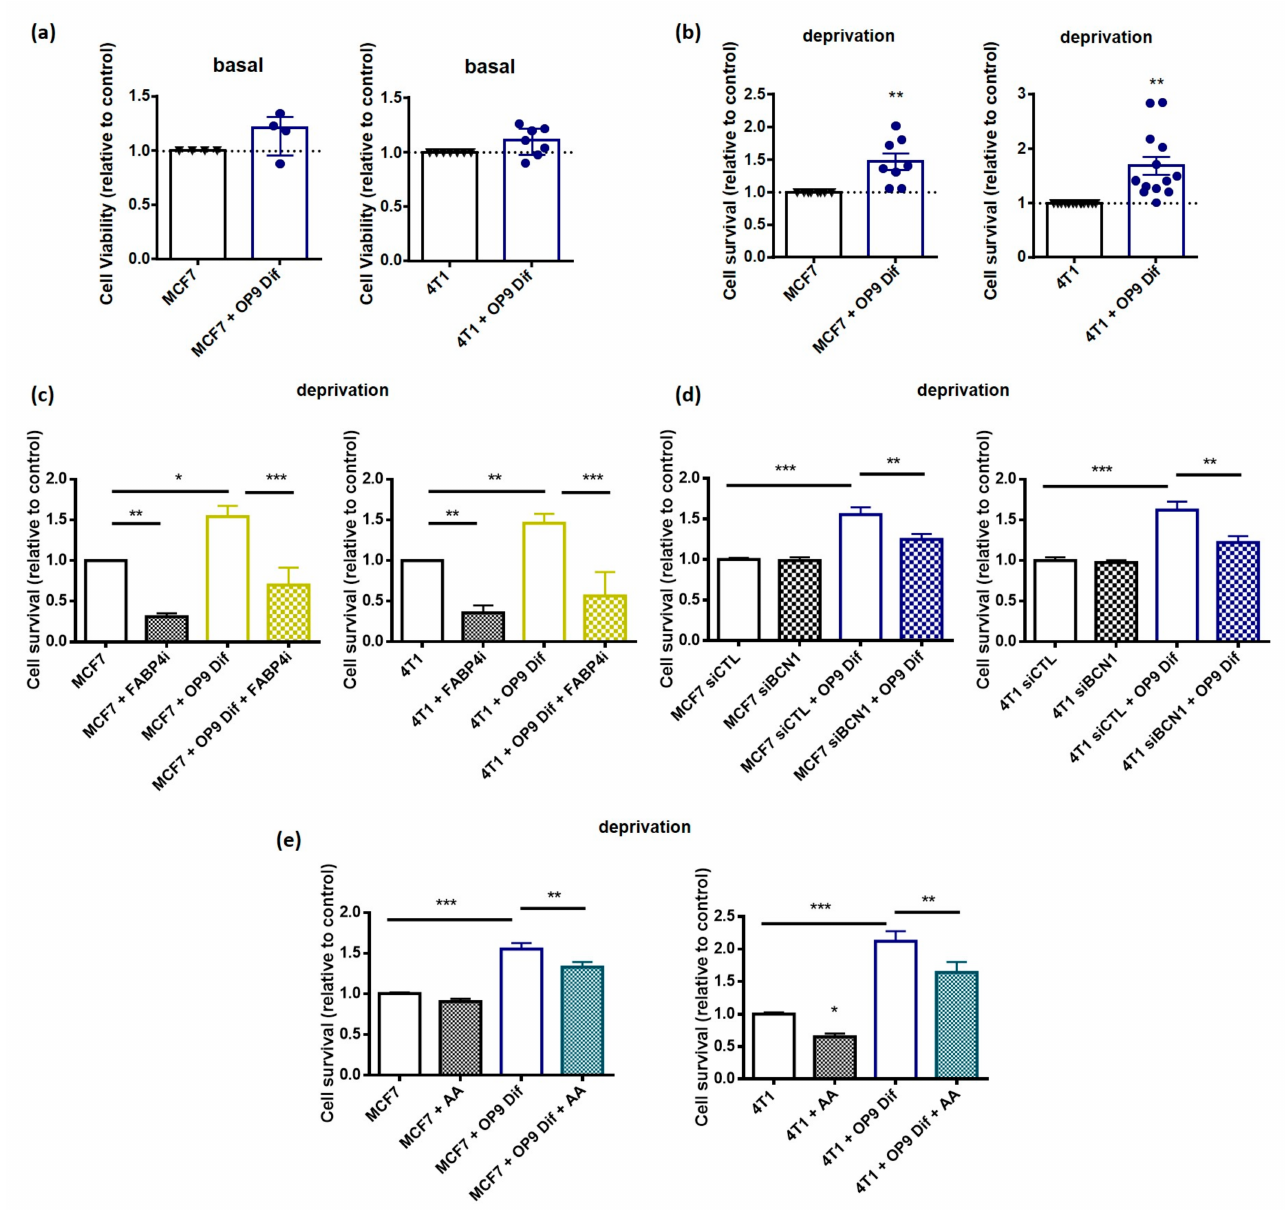
Figure 6. Activation of autophagy by adipocytes promotes cancer cell survival in nutrient-deprived conditions. ( a ) Cell viability assay in MCF7 and 4T1 cells with and without OP9 Dif in basal medium for 48 h (Median ± interquartile range, Wilcoxon Signed Rank Test ns n = 4–7). ( b ) Cell survival assay in MCF7 and 4T1 cells with and without OP9 Dif in HBSS deprivation medium for 48 h (Mean ± SEM, One sample t test ** p < 0.01, n = 8–13). ( c ) MCF7 and 4T1 cells with and without OP9 Dif in HBSS deprivation medium were treated by FABP4i (10 µ M) for 48 h and cell survival assay was performed (Mean ± SEM, One-way ANOVA followed by Holm–Sidak’s multiple comparisons test * p < 0.05; ** p < 0.01 and *** p < 0.001, n = 5–6). ( d ) Cell survival assay of MCF7 and 4T1 cells transfected with siCTL and siBCN1 with and without OP9 Dif in HBSS deprivation medium for 48 h (Mean ± SEM, One-way ANOVA followed by Holm–Sidak’s multiple comparisons test ** p < 0.01 and *** p < 0.001, n = 9–10). ( e ) Cell survival assay of MCF7 and 4T1 cells treated with arachidonic acid (AA) 20 µ M with and without OP9 Dif in HBSS deprivation medium for 48 h (Mean ± SEM, One-way ANOVA followed by Holm–Sidak’s multiple comparisons test * p < 0.05; ** p < 0.01 and *** p < 0.001, n =